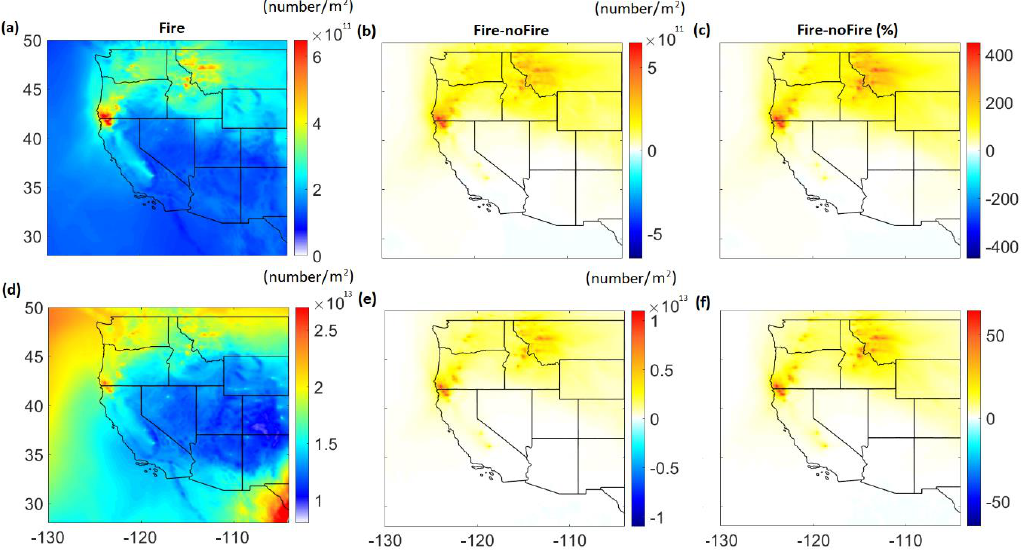
Figure 14. Spatial distribution of average ( a ) vertically integrated cloud condensation nuclei (CCN) concentration in number/m 2 at supersaturation S = 0.05% from the ‘Fire’ simulation (also referred to as CCN 0.05 in text) and ( b ) difference in CCN 0.05 in number/m 2 between the ‘Fire’ and ‘noFire’ simulations, ( c ) percentage difference in CCN 0.05 in number/m 2 between the ‘Fire’ and ‘noFire’ simulations relative to the ‘noFire’ simulation, ( d ) vertically integrated cloud condensation nuclei (CCN) concentration in number/m 2 at supersaturation S = 0.5% from the ‘Fire’ simulation (also referred to as CCN 0.5 in text) and ( e ) difference in CCN 0.5 in number/m 2 between the ‘Fire’ and ‘noFire’ simulations, ( f ) percentage difference in CCN 0.5 in number/m 2 between the ‘Fire’ and ‘noFire’ simulations relative to the ‘noFire’ simulation for the first half of September 2017.